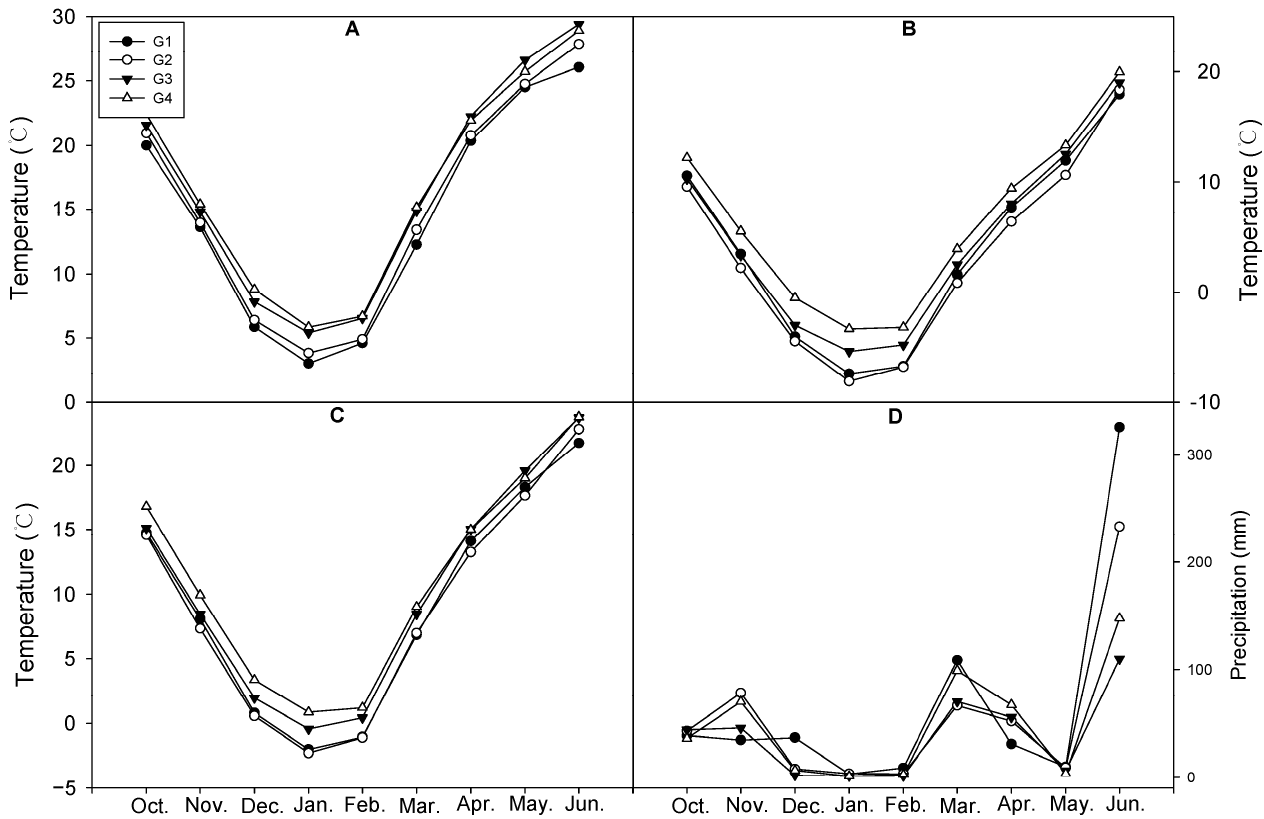
Figure 3. Maximum ( A ), minimum ( B ), daily average temperatures ( C ), and precipitation ( D ) in different group areas during experiment period in October 2021 to June 2022.